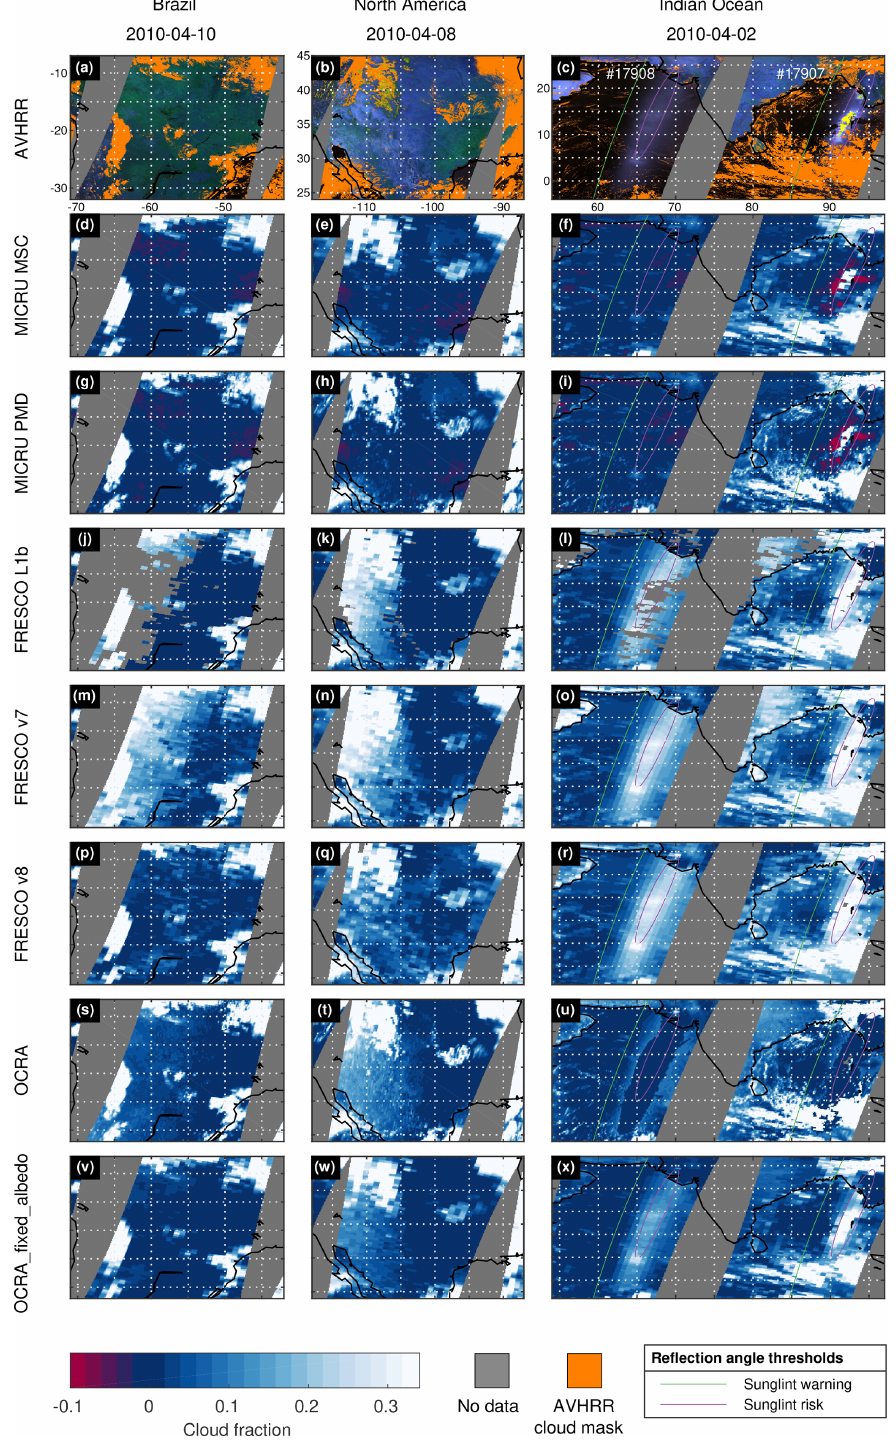
Figure 13. Detailed comparison between different cloud fraction products over cloud-free scenes over land and ocean: Brazil on 10 April 2010 (left column), North America on 8 April 2010 (second column), and the Indian Ocean on 2 April 2010. The rows display cloud informa- tion from different sensors/products (from top to bottom): AVHRR false colour RGB image indicating areas where at least one AVHRR cloud test is positive (orange), MICRU MSC at 440nm, MICRU PMD-PP at 460nm, three FRESCO versions, OCRA, and OCRA_fixed_albedo. The colour bar is defined to resolve cloud fractions particularly below 0.3 and negative values. Areas without data are indicated in gray. Images in the right column contain swath data of two orbits featuring different sun glitter scenarios due to different wind conditions (see